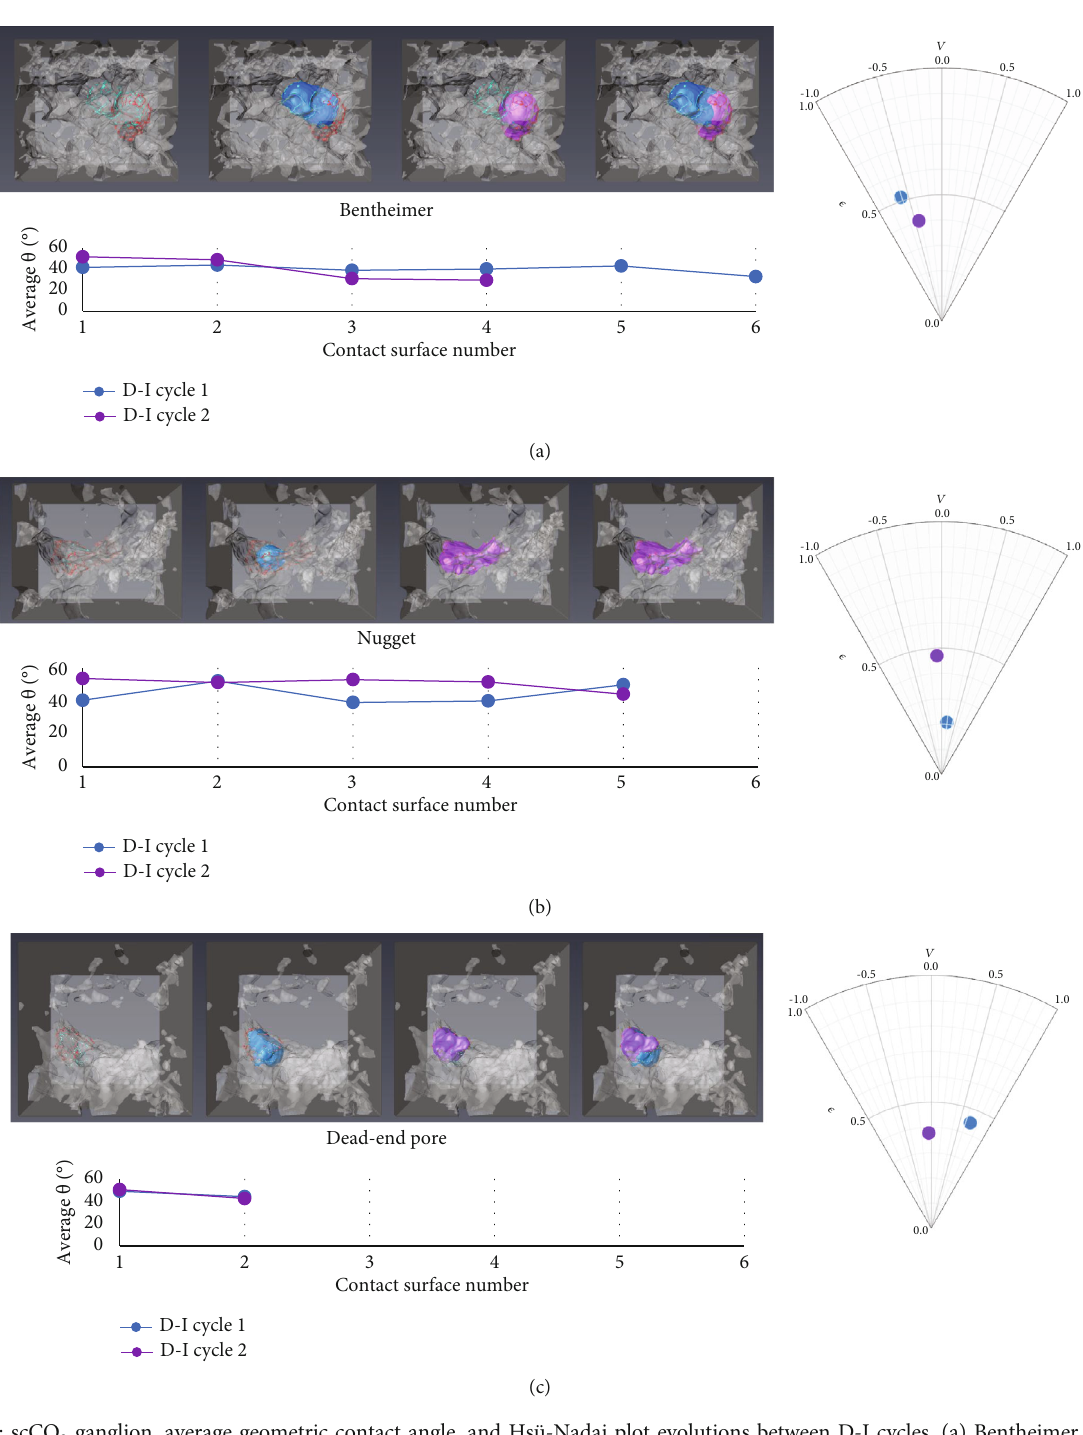
Figure 8: scCO ganglion, average geometric contact angle, and Hsü-Nadai plot evolutions between D-I cycles. (a) Bentheimer pore, (b) 2 Nugget pore, and (c) Nugget dead-end